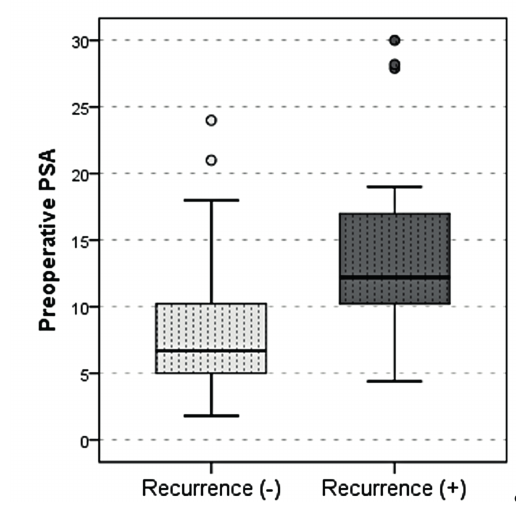
Figure 2 - Preoperative PSA levels and association with biochemical